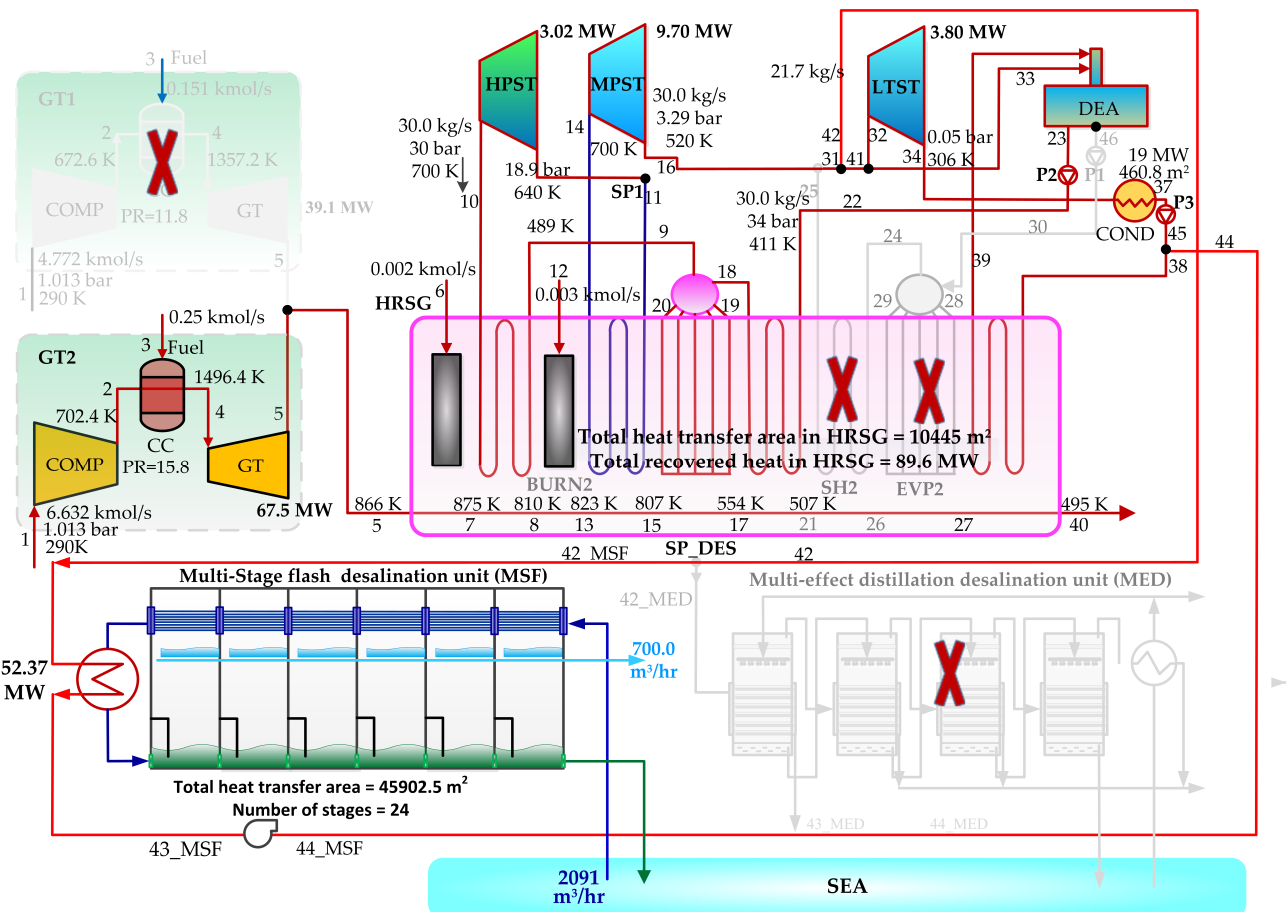
Figure 6. Sub-optimal configuration of the integrated power/desalination process obtained by minimizing the total annual cost to generate 80.0 MW of net electrical power and 700 m 3 /h of freshwater (Config. #3).